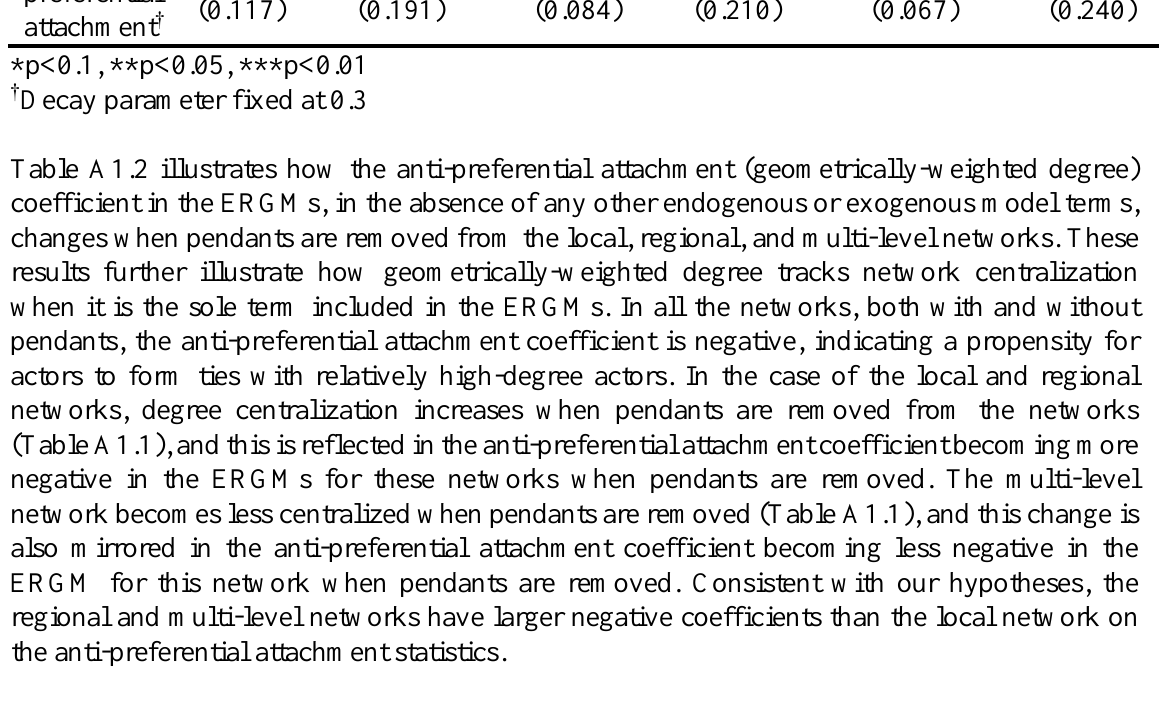
Table A1.3: ERGM results illustrating the effects of removing pendants on the coefficient for shared partners, in the absence of any other endogenous or exogenous model